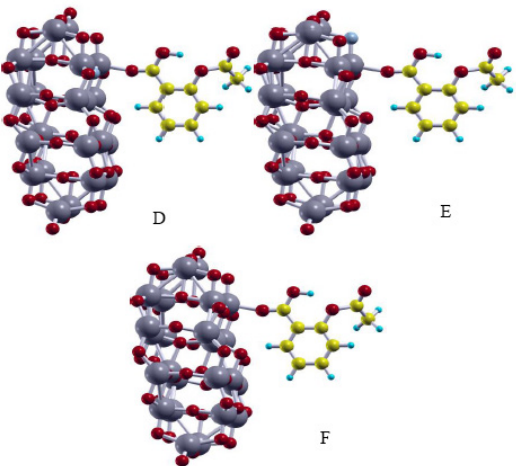
Fig. 5. Optimized TiO -Aspirin complexes with parallel adsorption 2 configurations. Colors represent atoms accordingly: Ti in gray, O in red, N in blue, C in yellow and H in cyan.